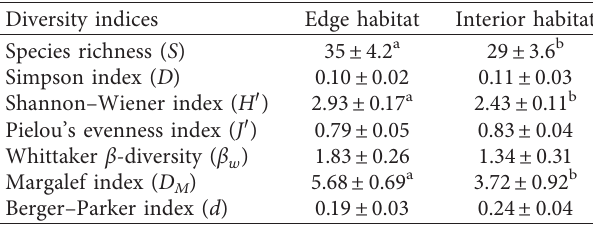
Table 3: Mean ( ± SE) values of species richness and diversity